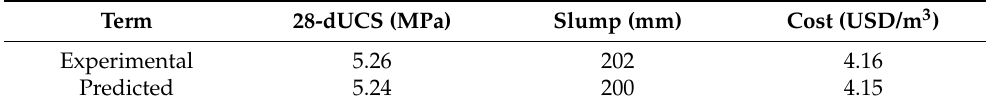
Table 4. Comparison of predicted values and actual values of the CPB samples with the optimal mix ratios.